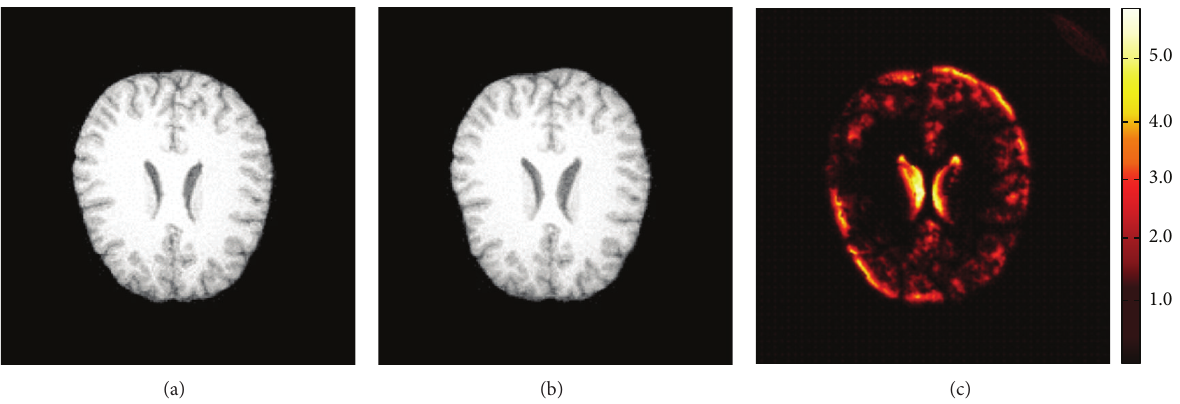
Figure 3: (a) Floating image. (b) Target image obtained by deforming the floating image with the known deformation field. (c) The known deformation field is obtained from FEM-based deformable registration